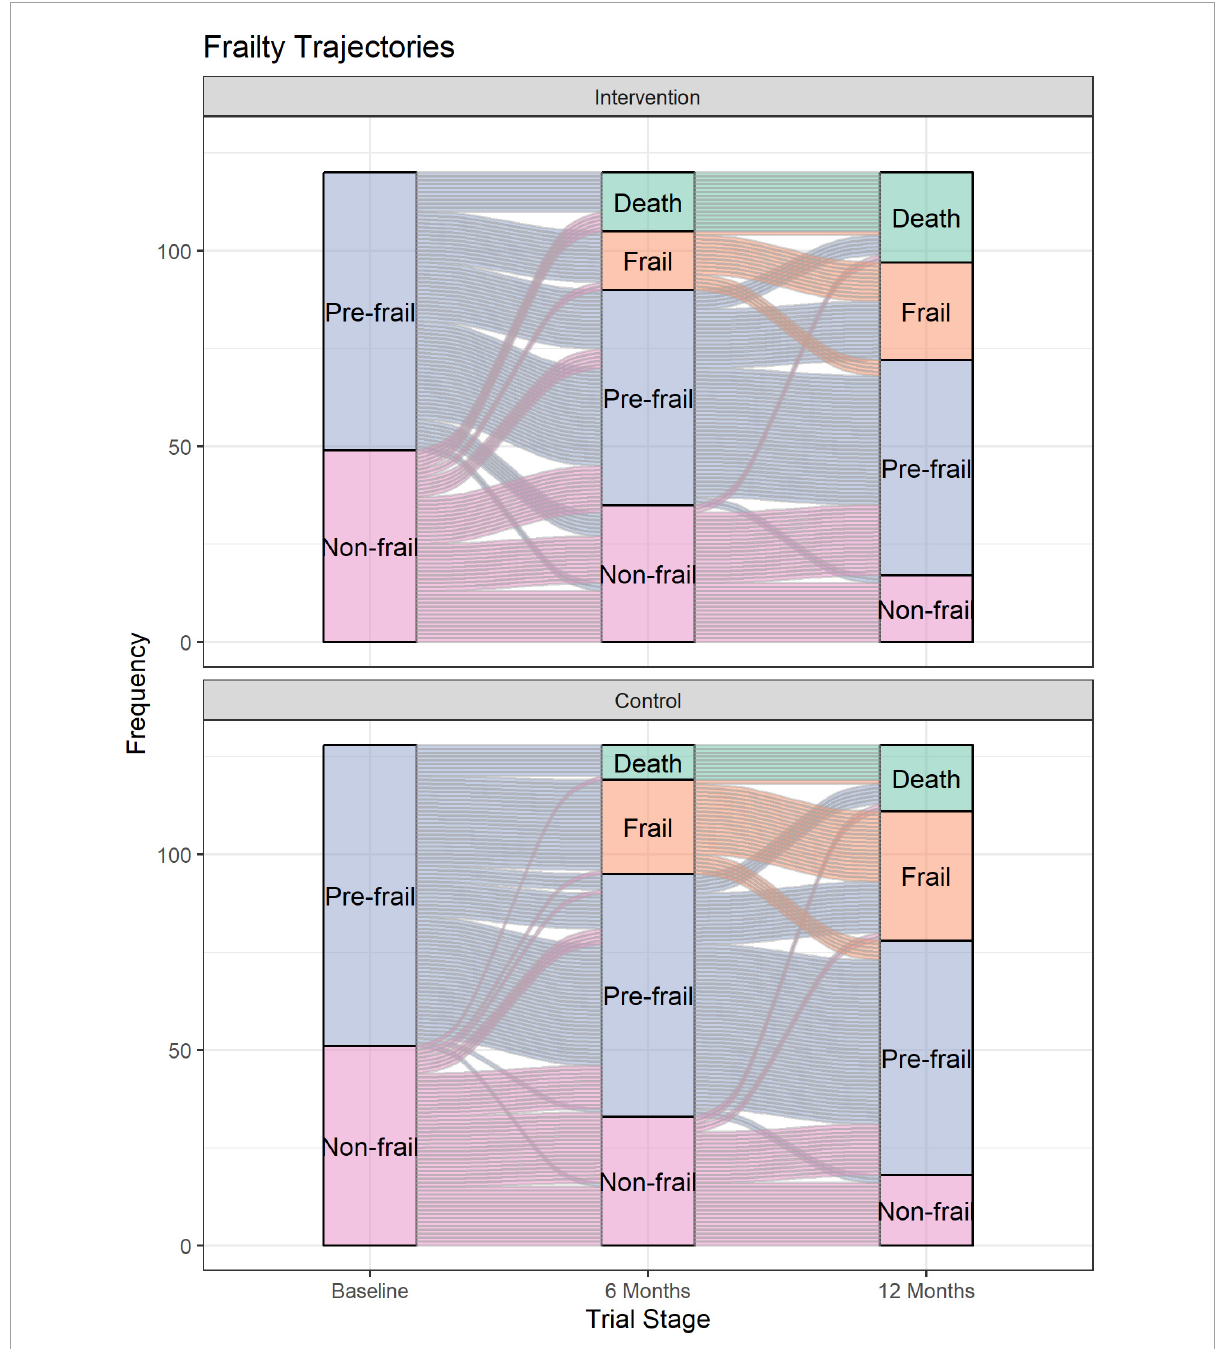
FIGURE2 Frailty trajectory for intervention (Top) and control (Bottom) groups.